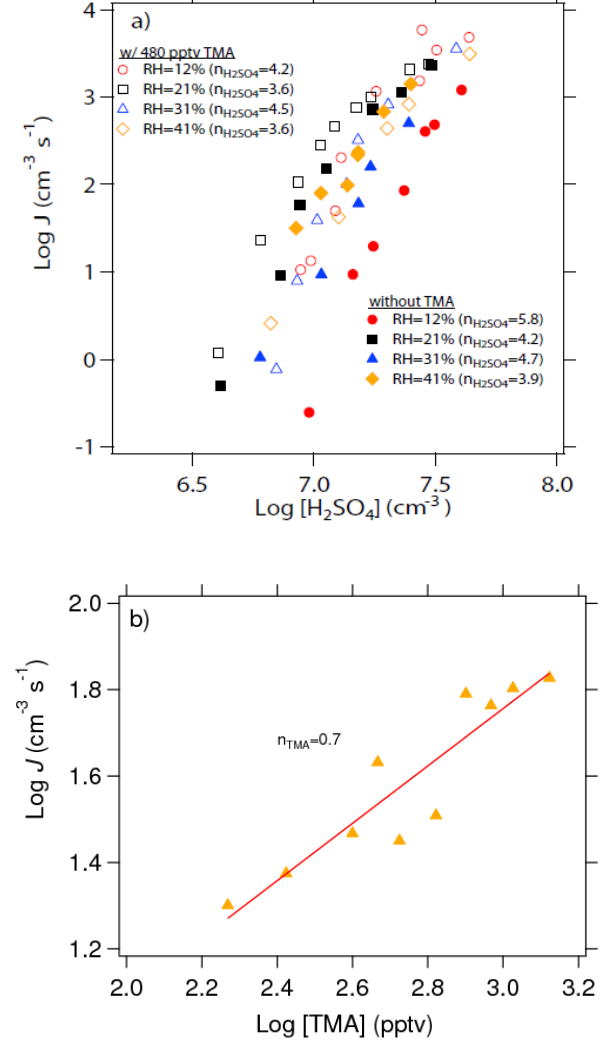
Fig. 2. (a) The measured Log J vs. Log [H 2 SO 4 ] at RH of 12–41% Figure 2. a) The measured Log J vs. Log [H 2 SO 4 ] at RH of 12 - 41% without (filled symbols) 478 without (filled symbols) and with TMA (480pptv) (open symbols). The total flow in the reactor was maintained at 2lpm, correspond- and with TMA (480 pptv) (open symbols). The total flow in the reactor was maintained at 2 lpm, 479 ing to residence time of ∼ 50s. The range of [H 2 SO 4 ] was from 5 × 10 6 − 1 × 10 8 cm − 3 . For clarity, linear fitting lines of the data corresponding to residence time of ~ 50 s. The range of [H 2 SO 4 ] was from 5×10 6 - 1×10 8 cm -3 . 480 are not included here. The slope of the linear fittings ( n H 4–6 before adding TMA and 4–5 after adding TMA of 480pptv. (b) Log J vs. Log [TMA] (180–1350pptv). The flow rate in the re- actor was 5lpm translating to ∼ 20s residence time. The solid line shows the linear fitting of the data and n = TMA indicates the